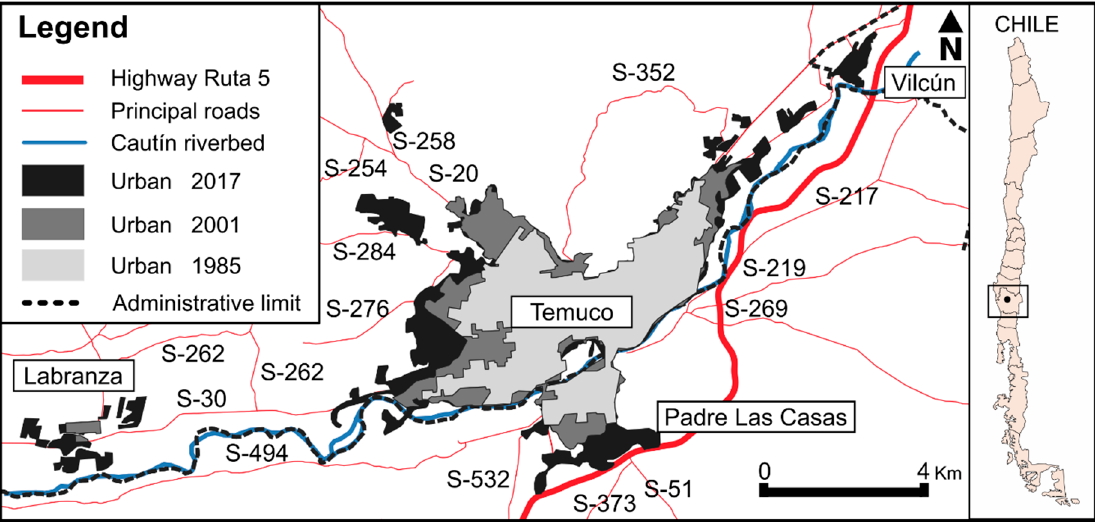
Figure 1. Study area and urban growth of the city of Temuco between 1985 and 2017. Source: Authors’ compilation.